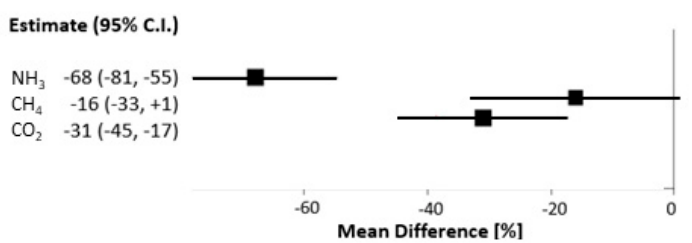
Figure 4. Forest plot of the impact of the use of covers during storage of animal slurry. The black square boxes show the individual mean points of each gas. Please note that N 2 O is missing in the forest plot due to the extreme values + 13502% (CI − 25, + 39600). Horizontal bars indicate the 95% confidence intervals.